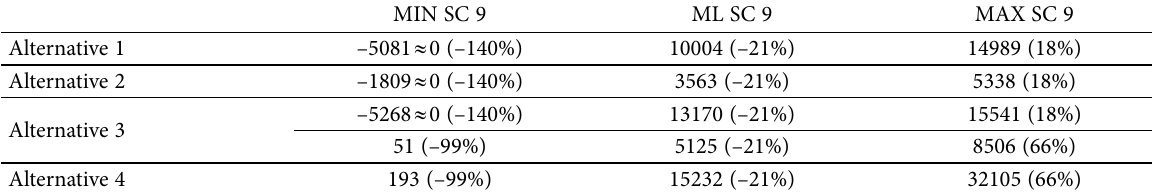
Table 11. Scenario 9 TTS-TR parameters to the Beta-PERT distribution [mDKK]